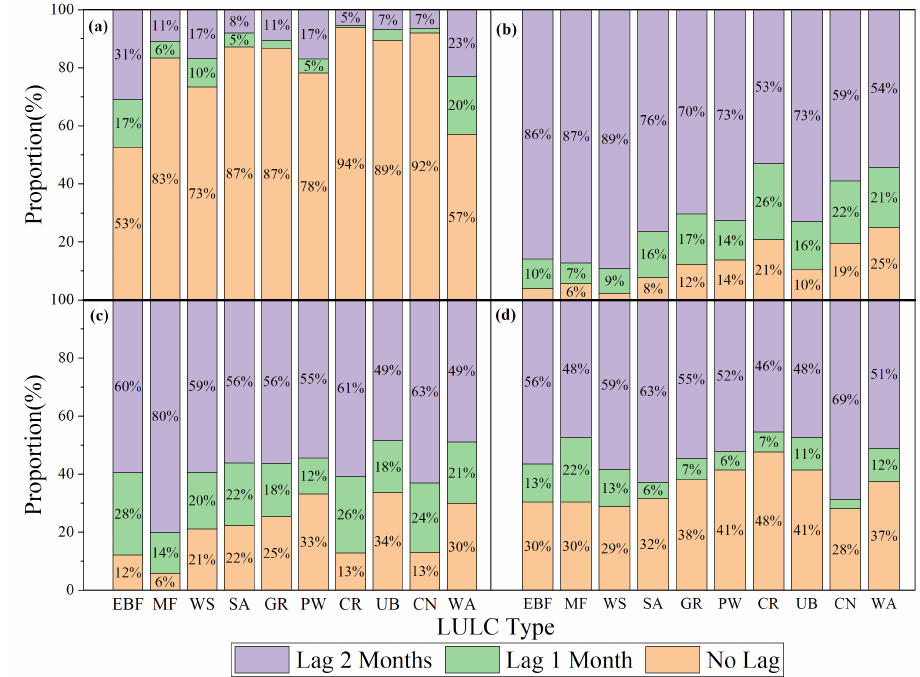
Figure 5. Time-lag effect of NDVI impact factors for each LULC type in Guangdong Province: ( a ) for temperature, ( b ) for precipitation, ( c ) for shortwave downgradient radiation, and ( d ) for CO 2